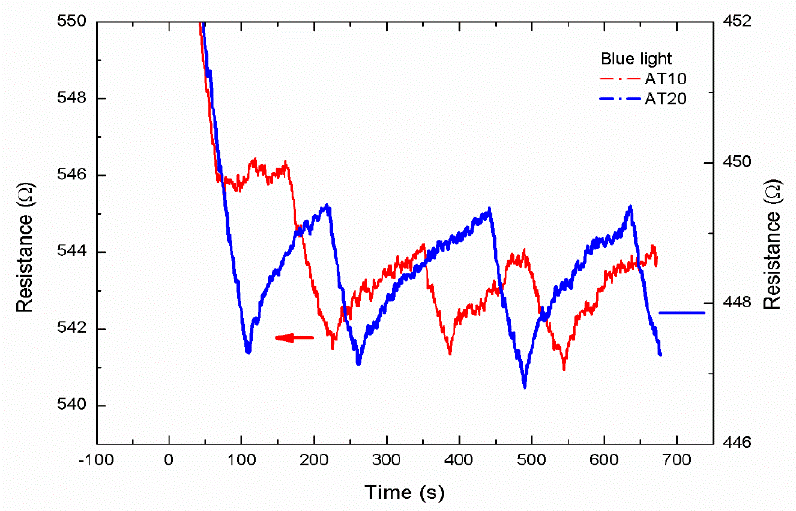
Figure 5. Ag-TiO 2 composite film is irradiated by blue light.